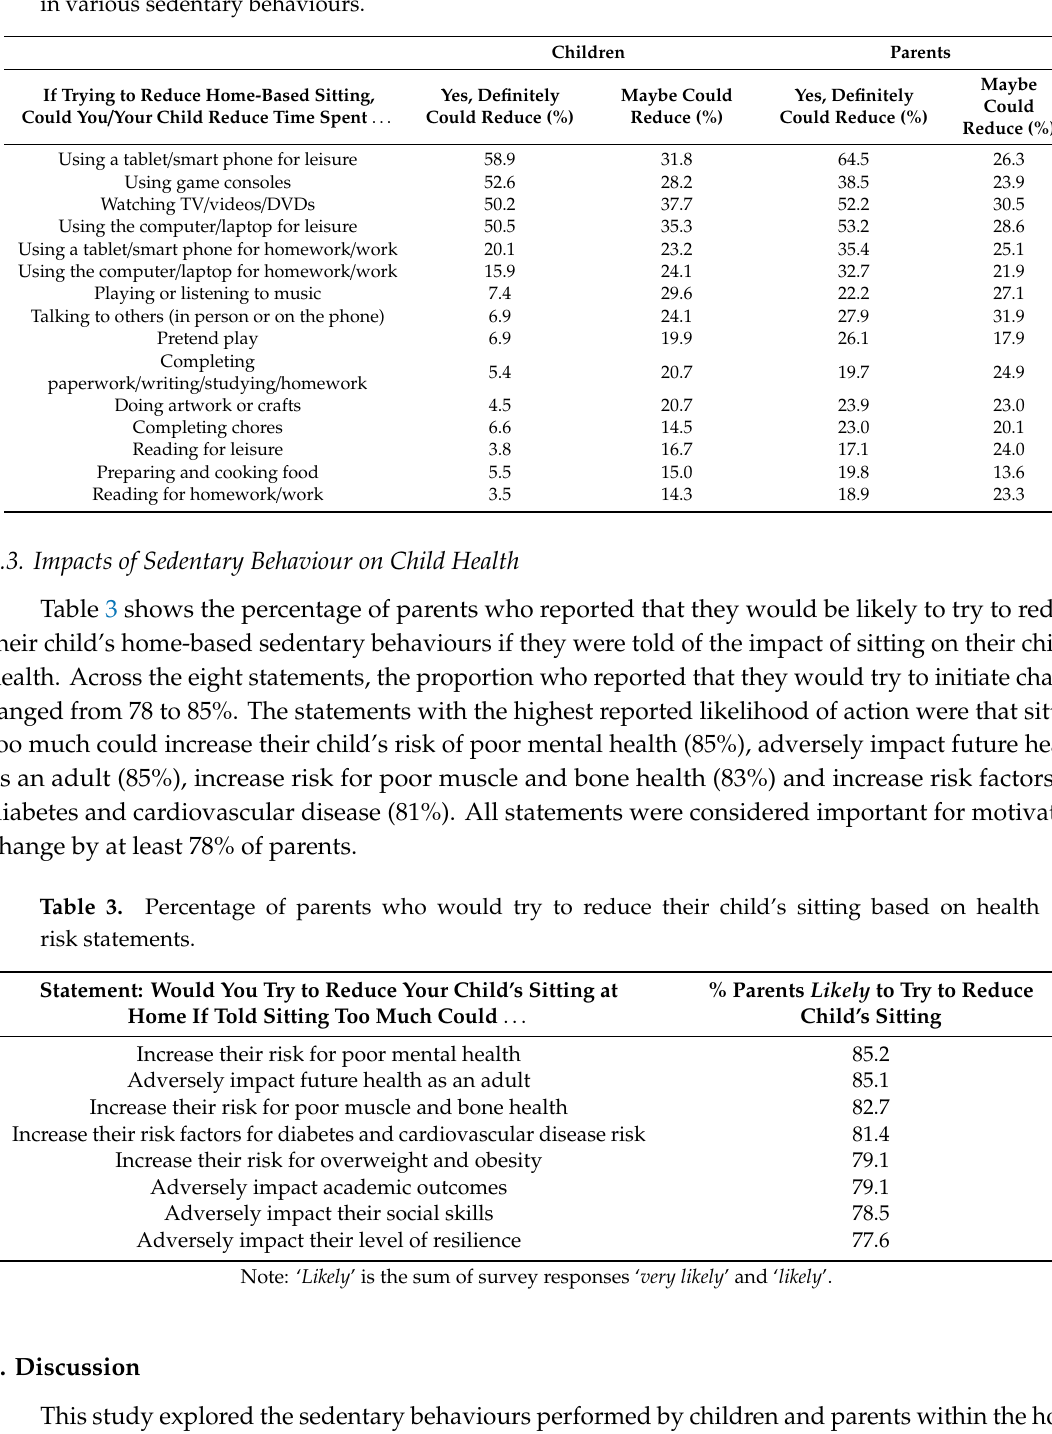
Table 2. The percentage of parents who reported they or their child could decrease the time they spend in various sedentary behaviours.